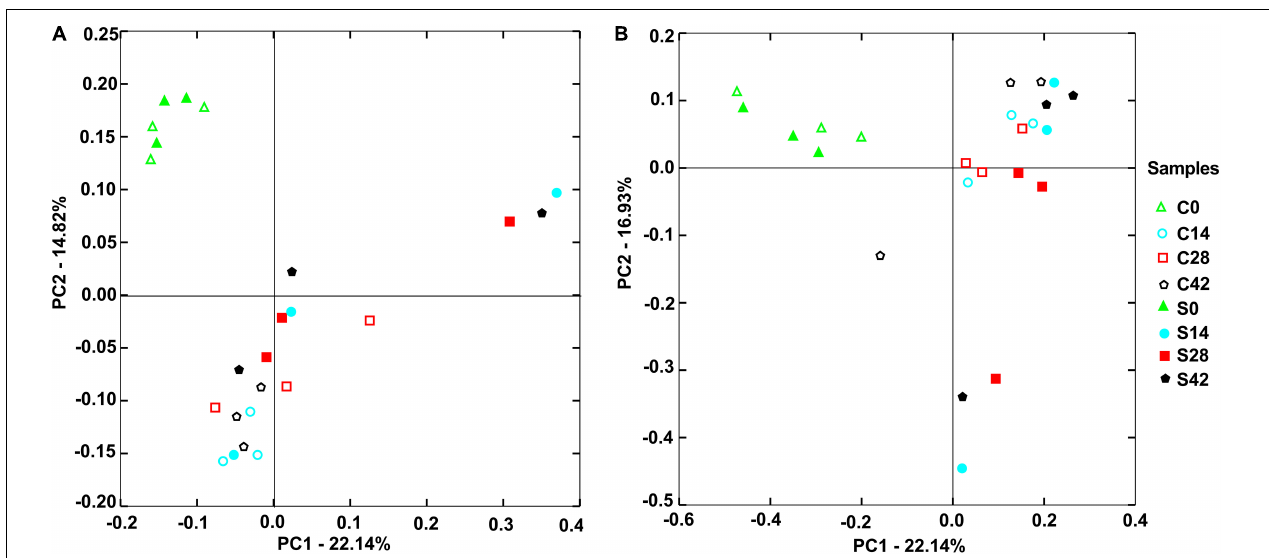
FIGURE 3 | Principal components analysis (PCA) showed distribution of samples. (A) Bacterial community and (B) fungal community. The closer distance between points shows the higher similarity; n = 3.